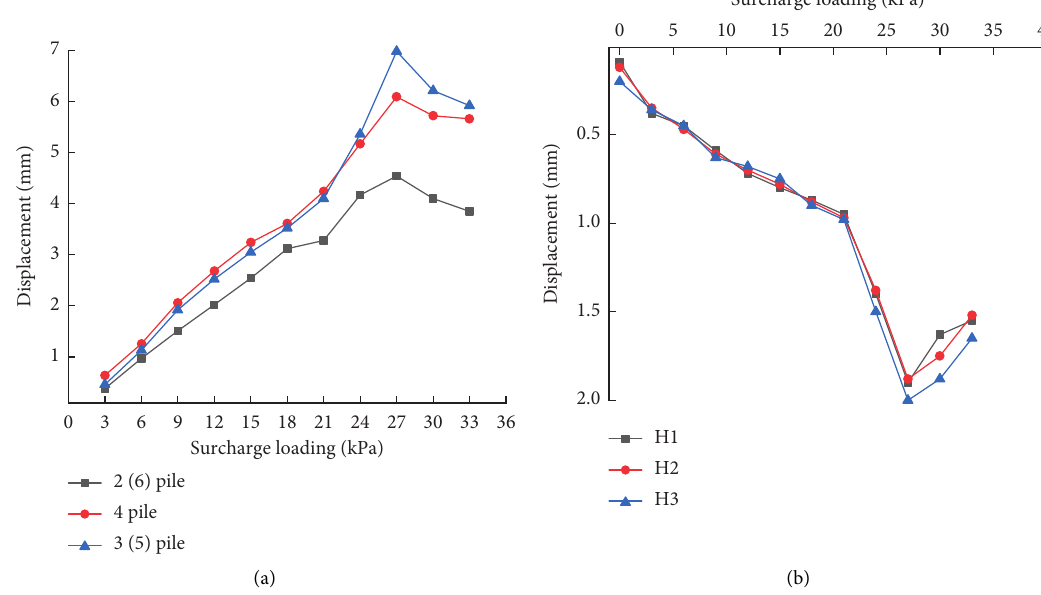
Figure 9: Pile top displacement and settlement. (a) Pile top displacement. (b) Foundation pit